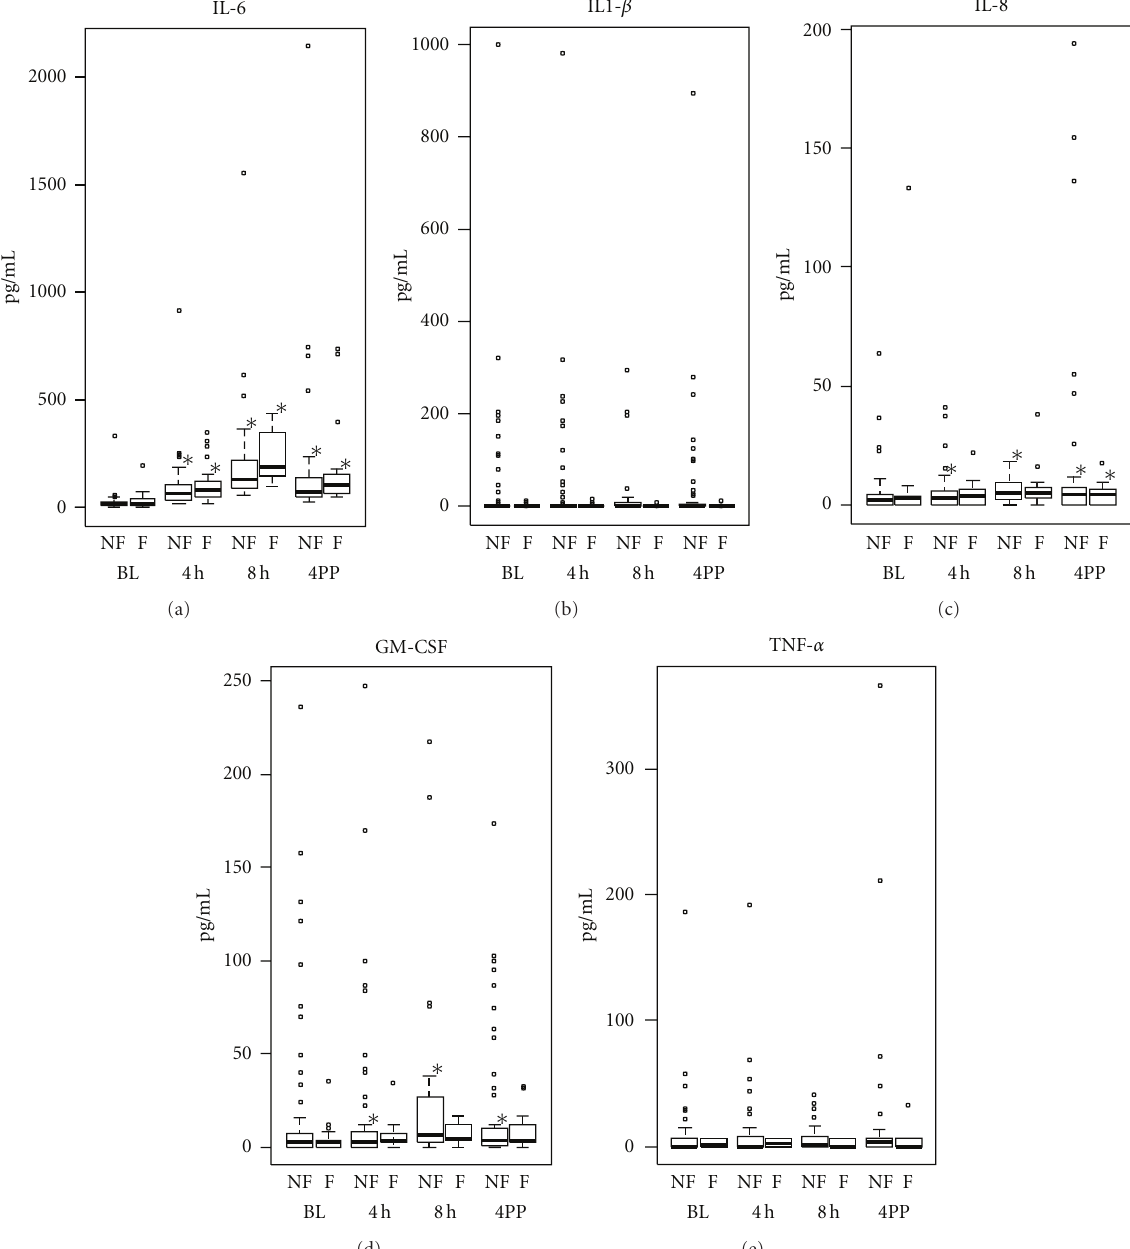
Figure 2: Box plots of intra- and intergroup maternal serum cytokine changes by fever status during labor epidural analgesia. IL- 6: interleukin-6, IL-1 β : interleukin-1 β , IL-8: interleukin-8, GM-CSF: granulocyte macrophage-colony stimulating factor, TNF- α :